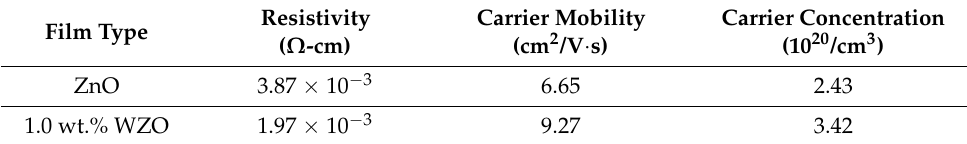
Table 1. Comparison of electrical properties between pure ZnO and 1.0 wt.% WZO films deposited at 300 ◦